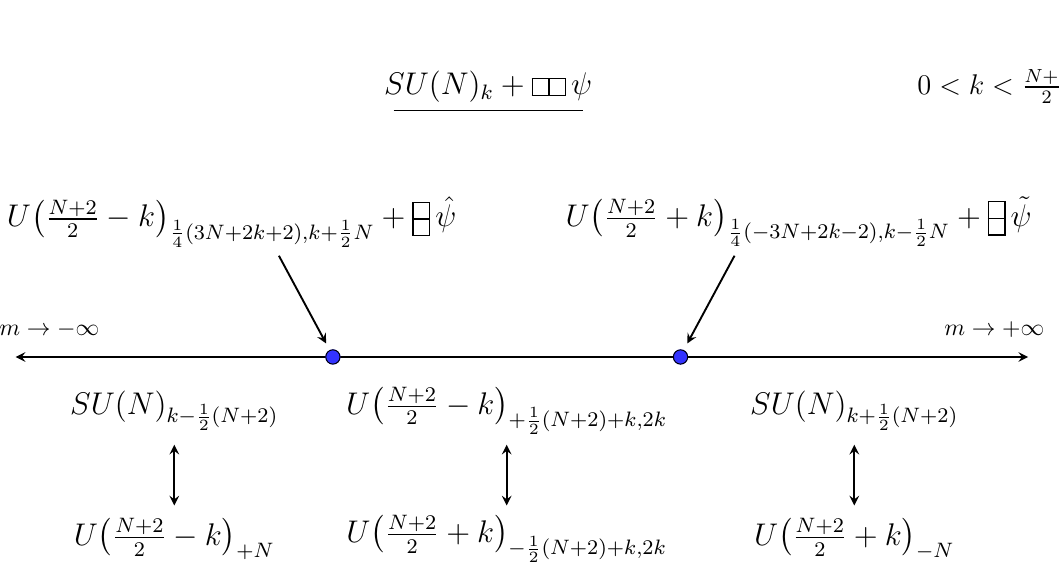
. The solid circles 2